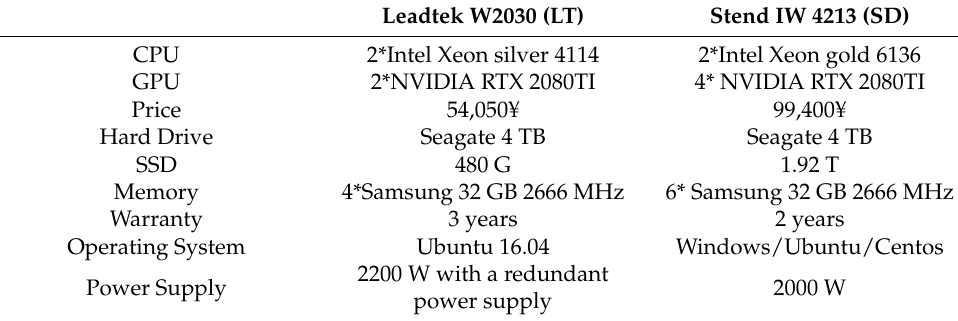
Table 6. Configuration information of the GPU